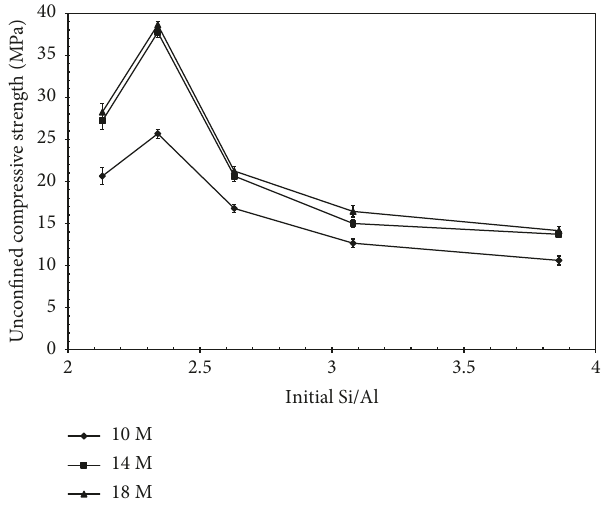
Figure 4: 7-day UCS versus initial Si/Al at different NaOH concentration.